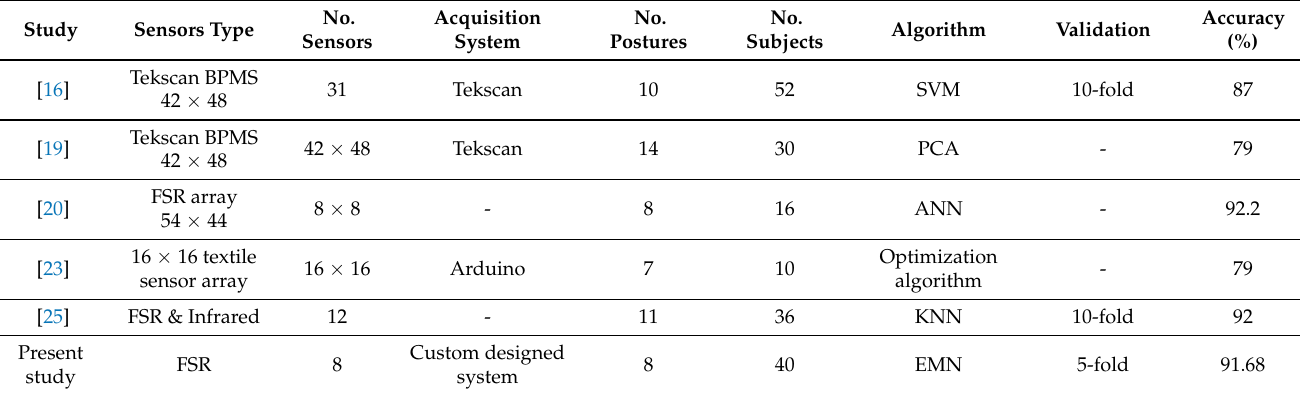
Table 3. The comparison between our approach and other methods and systems as published in the literature on sitting postures